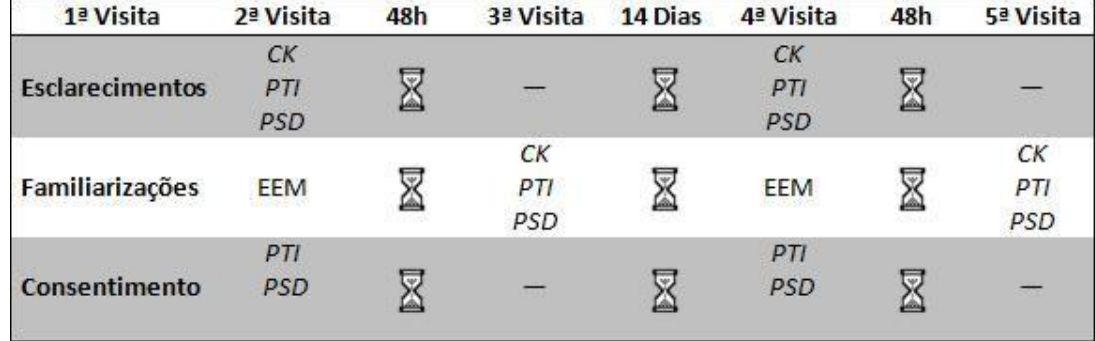
Figura 1. Delineamento experimental com as visitas realizadas ao laboratório e os procedimentos adotados. As siglas em itálico representam coletas